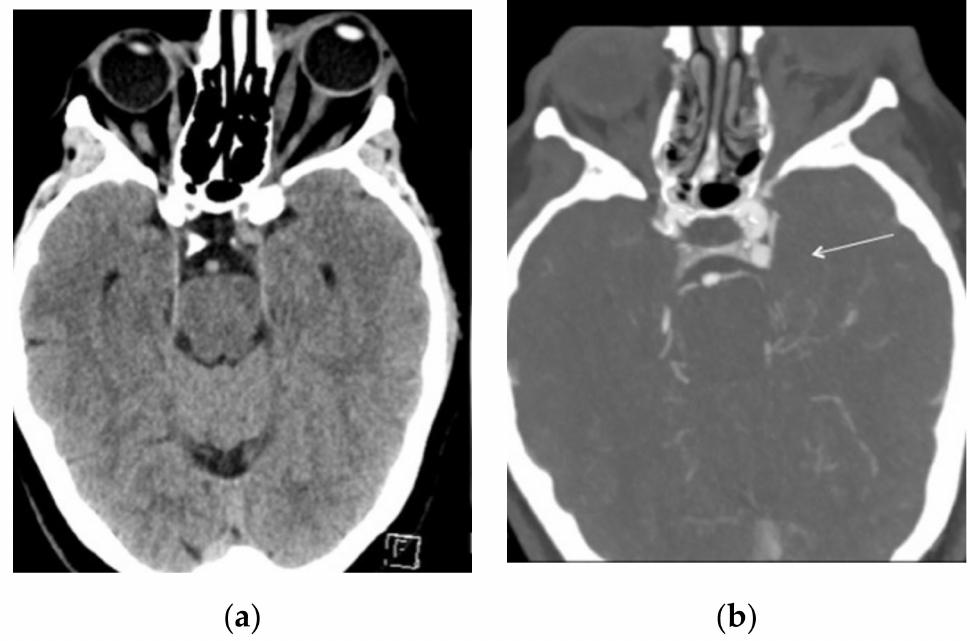
Figure 2. ( a ) CT scan on admission showing left exophthalmos with hypertrophic extrinsic ocular muscles. ( b ) CT angio on the same day demonstrating a small venous pouch on the posterior aspect of the left cavernous sinus (white